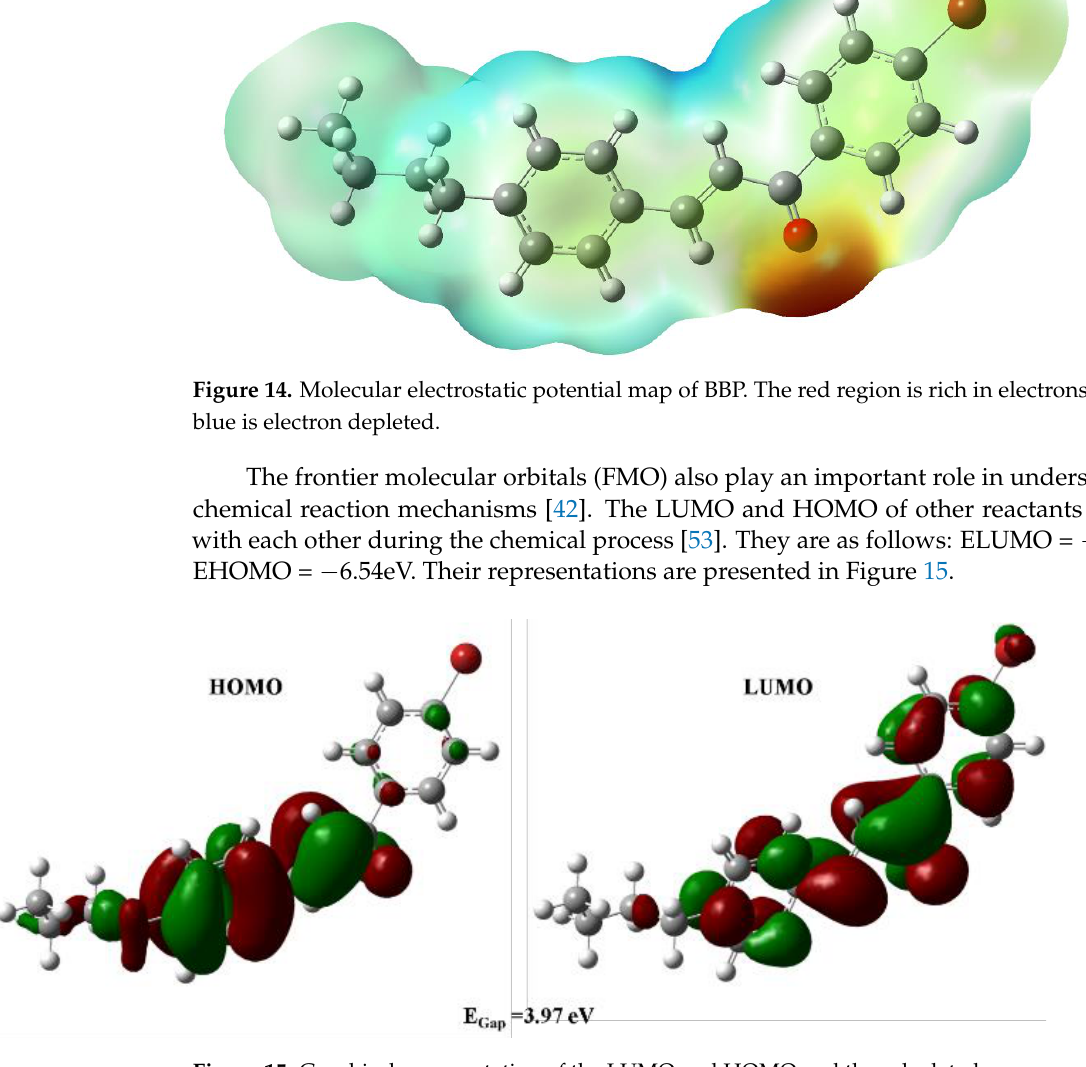
Figure 15. Graphical representation of the LUMO and HOMO and the calculated energy gap for